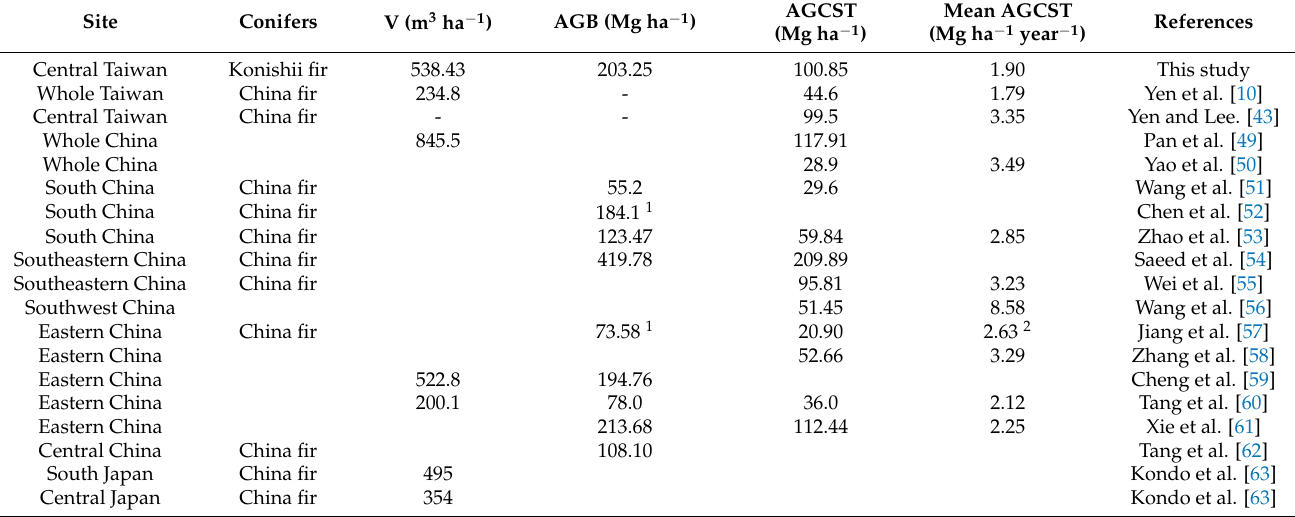
Table 8. Stand volume (V), aboveground biomass accumulation (AGB), and aboveground carbon storage (AGCST) for the Konishii fir or Chinese fir plantations collected from publication papers at various regions compared to our study.